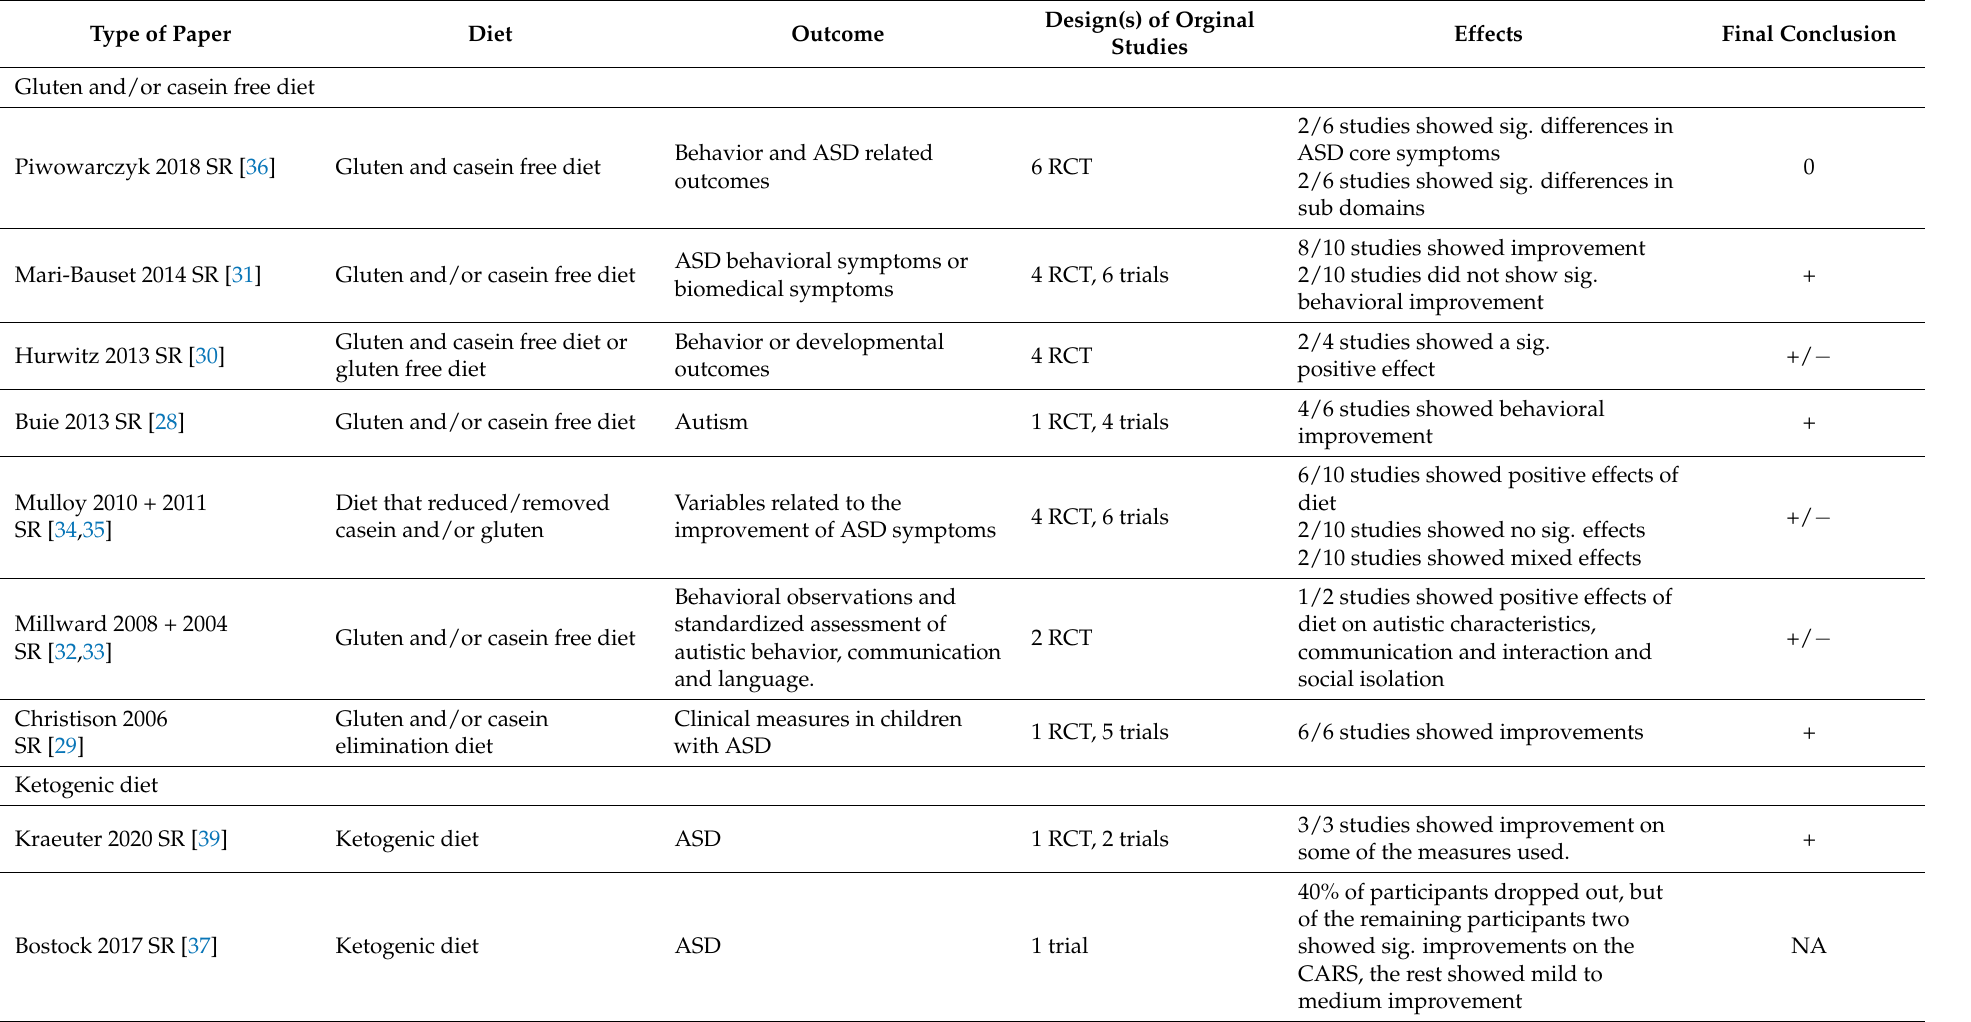
Table 2. Meta-analyses and systematic reviews concerning therapeutic diets and specific food products for